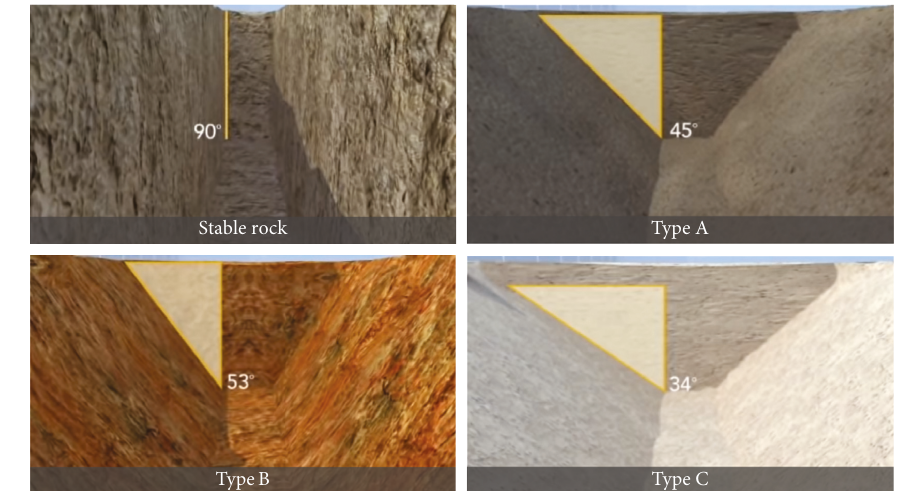
Figure 4: OSHA prevention videos (v-tools) for